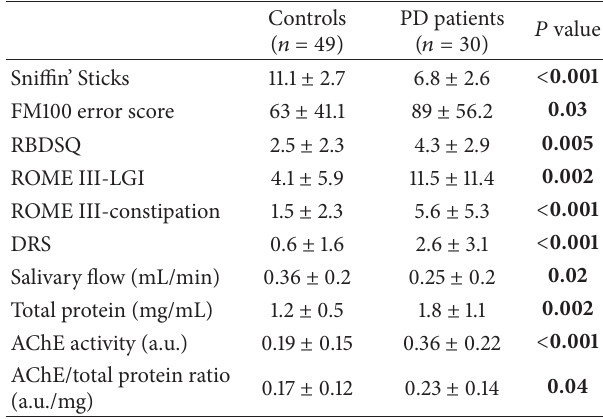
Table 1: Clinical and demographic characteristics of patients and controls.